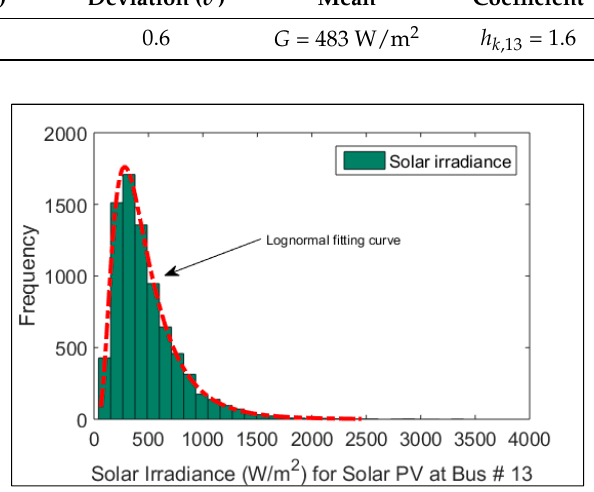
Figure 4. Distribution of solar irradiance at bus #13.